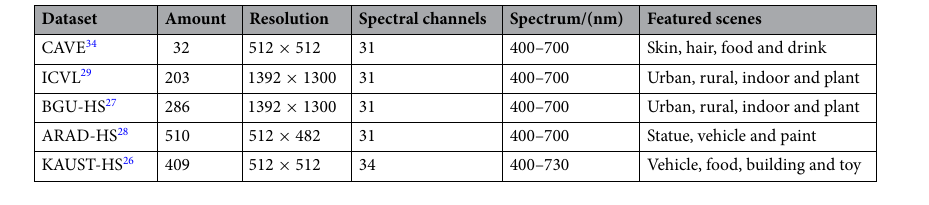
Table 1. Properties of five open-source hyperspectral